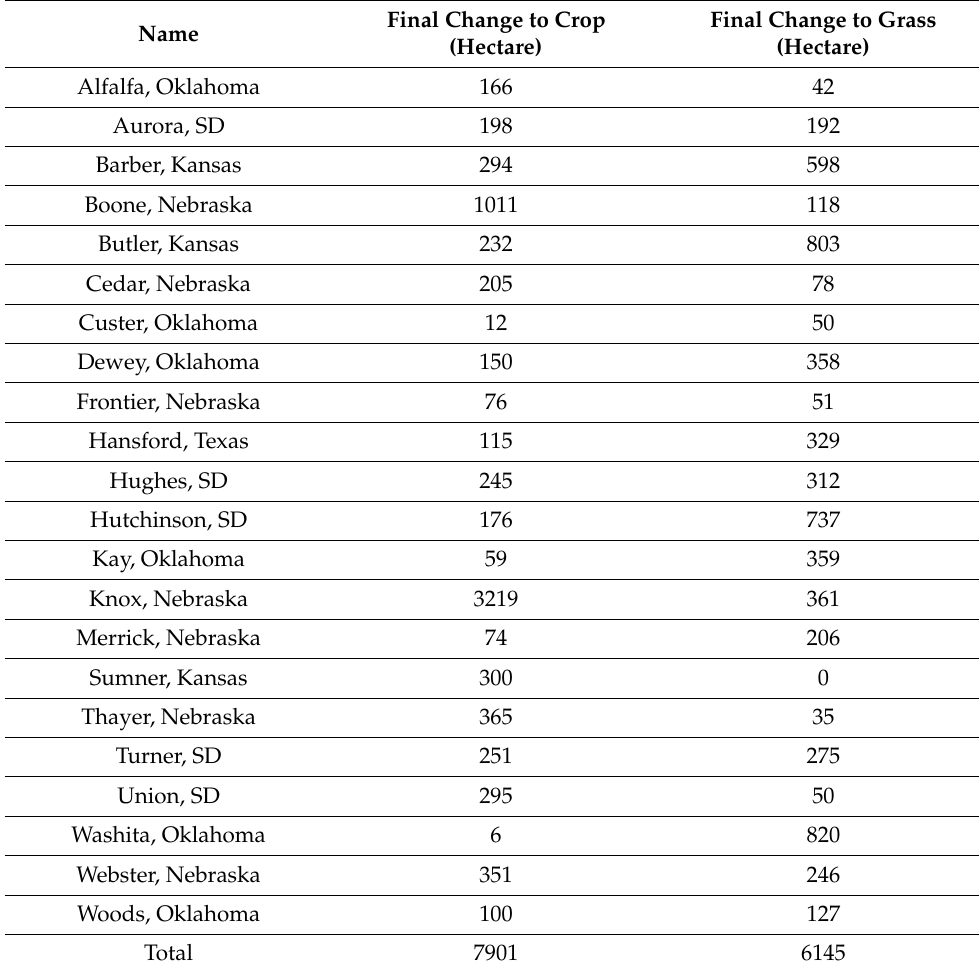
Table 4. Total Hectares found to have potentially changed to and from cropland in the 22 studied counties since